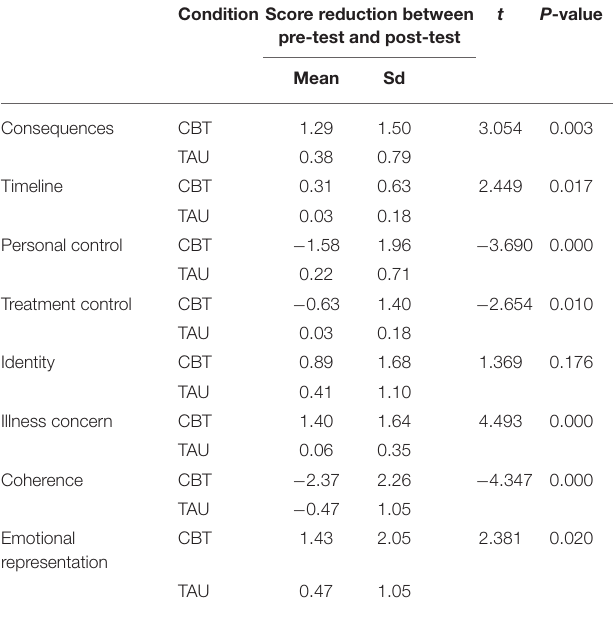
TABLE 4 | Comparison of BIPQ factors change between CBT group and TAU